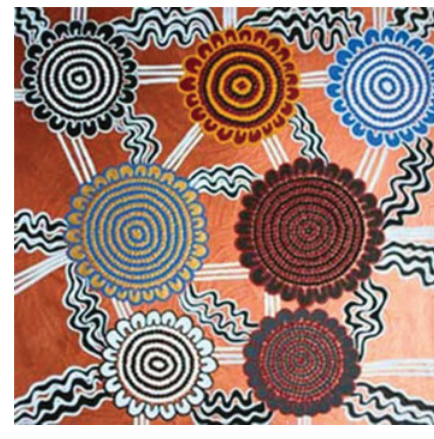
(Colour online) Through the Net (Denise Proud,